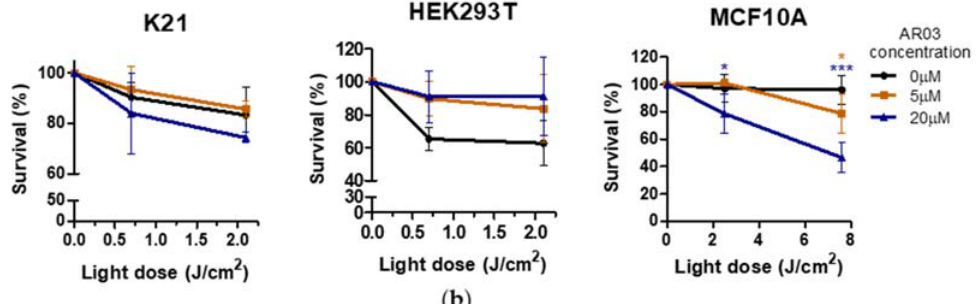
Figure 8. The effect of APE1 inhibition on non-cancer cell lines. ( a ) AR03 effect on K21, HEK293T, and MCF10A cells. ( b ) Influence of APE1 inhibitor combined with PDT treatment on K21, HEK293T, and MCF10A cells. Statistical significance was calculated by one-way or two-way ANOVA followed by Bonferroni test (* p ≤ 0.05, ** p ≤ 0.01, *** p ≤ 0.001).